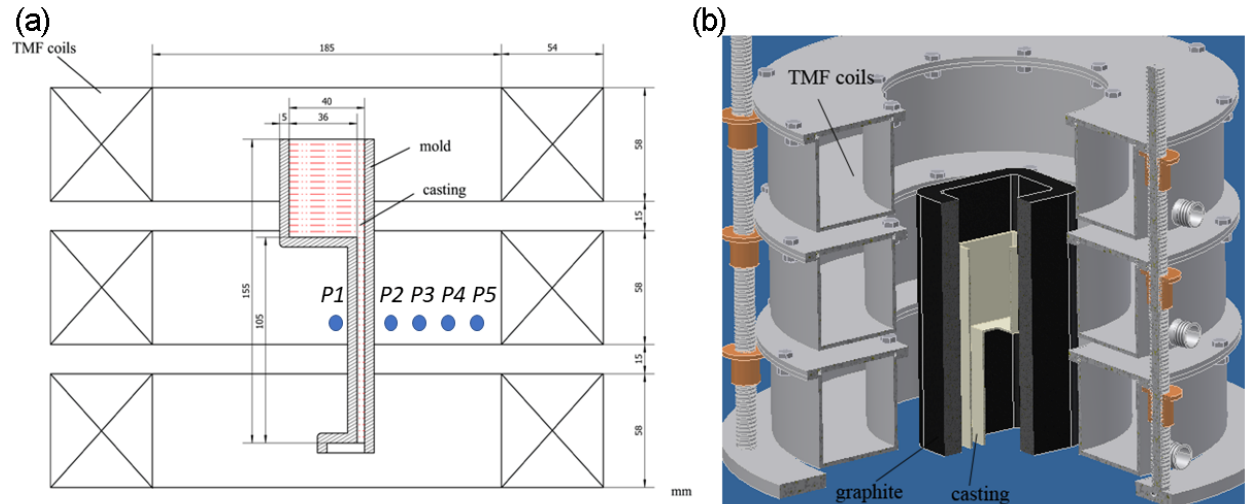
Figure 9. Experimental design: ( a ) geometry of the setup, and ( b ) a sketch of the setup.